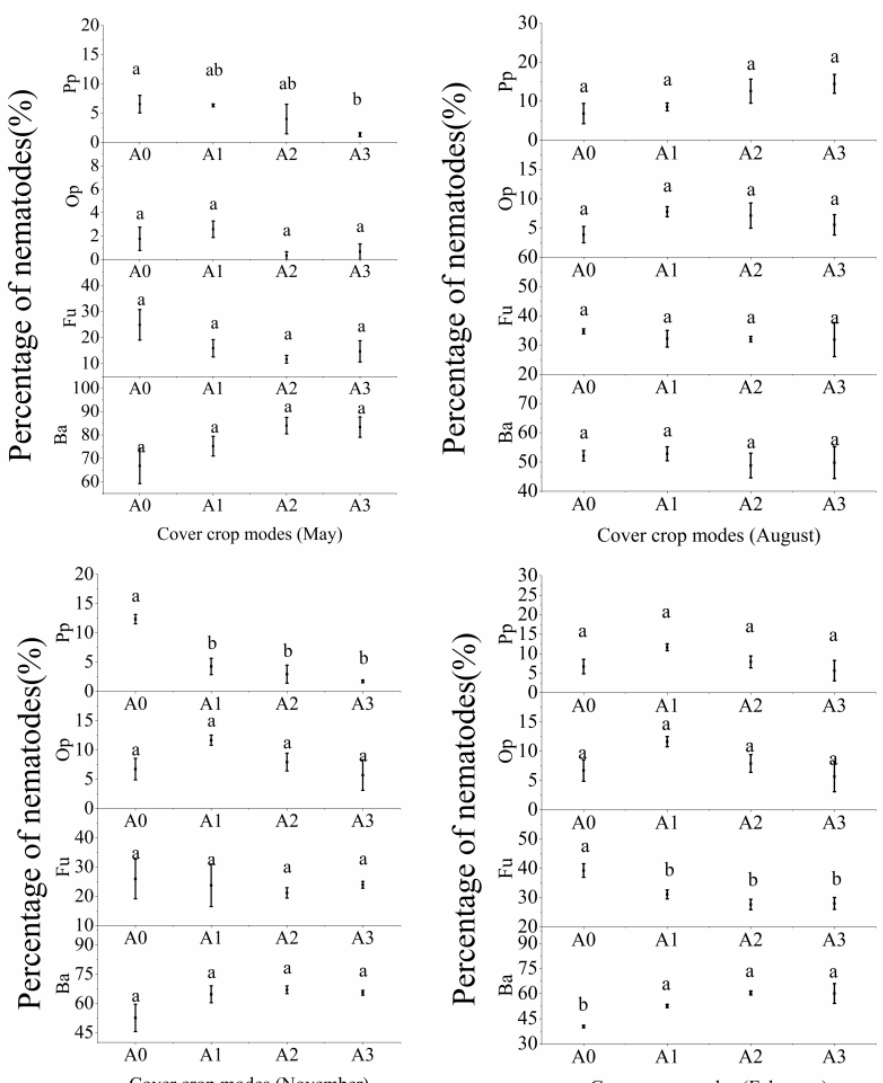
Figure 2. Changes in the nutritional groups of nematodes under different cover crop patterns. Different lowercase letters indicate that there are significant differences between different cover crop patterns in the same month ( p < 0.05). Ba, bacterivores; Fu, fungivores; Op, omnivores/predators; Pp, plant